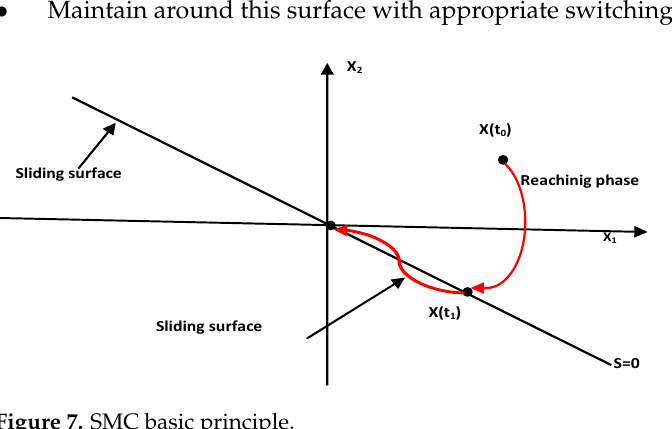
Figure 7. SMC basic principle.